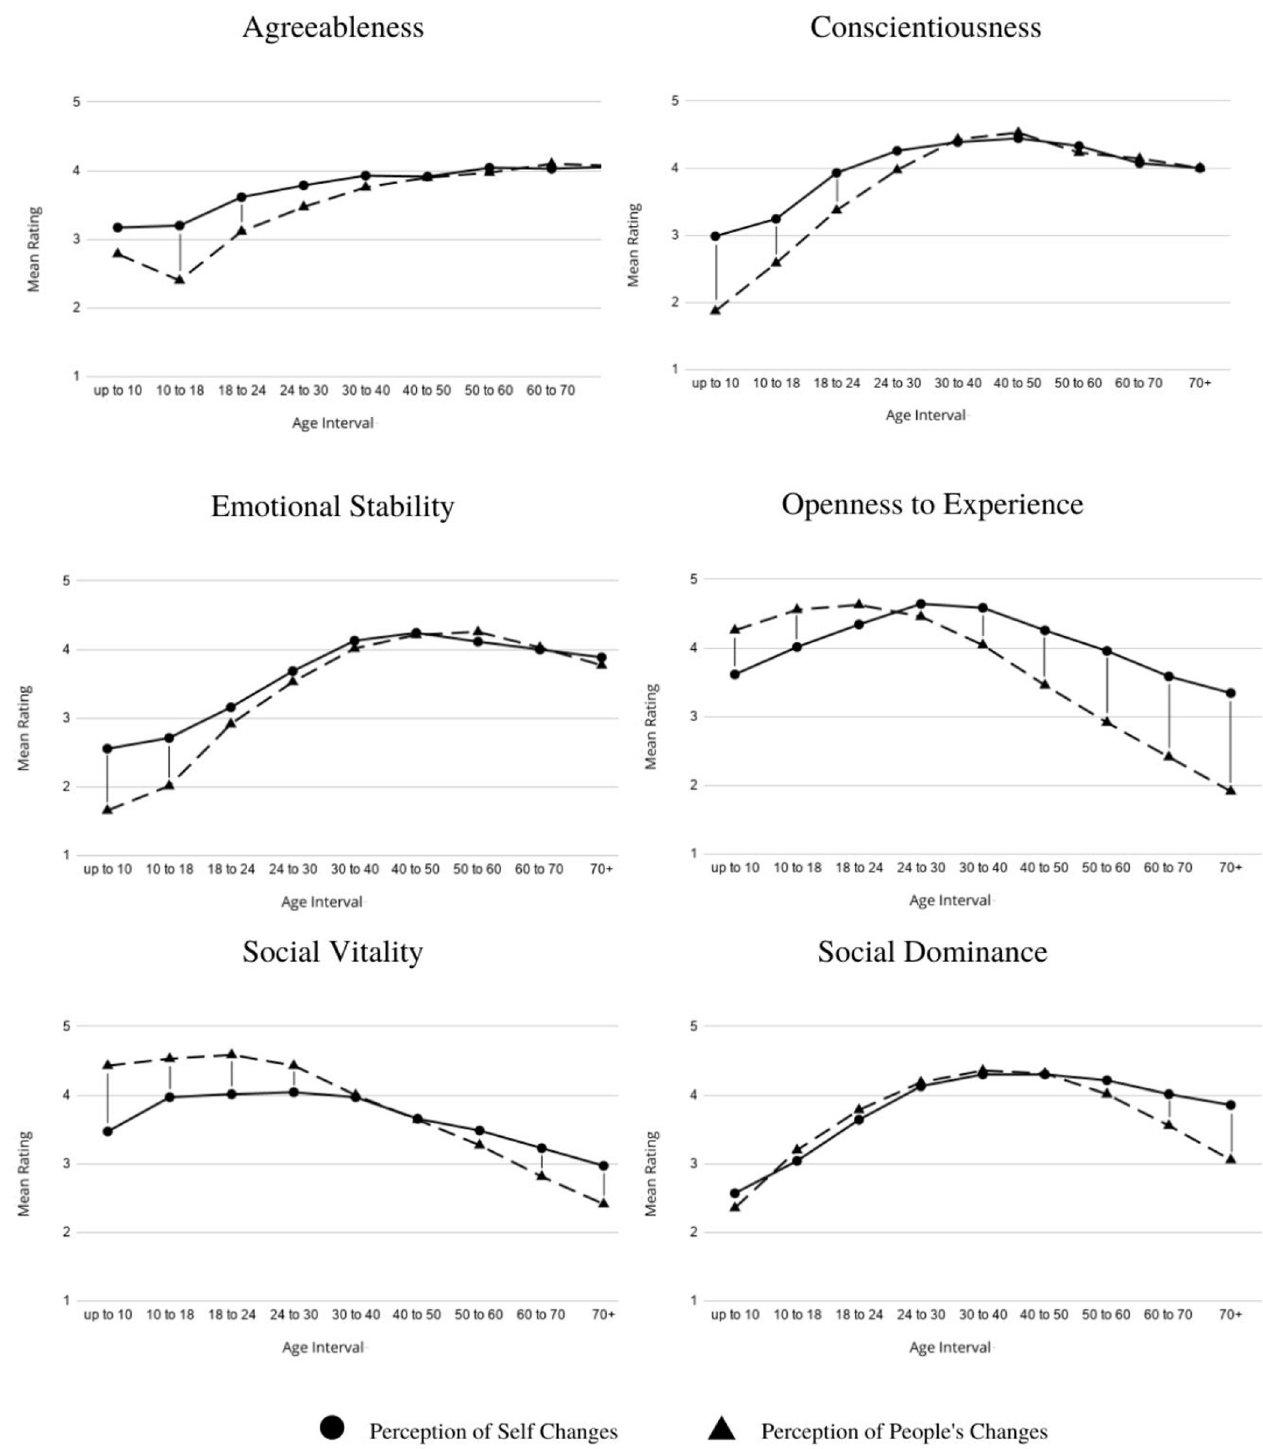
Fig 1. Mean ratings for the perception of changes of the self and the perception of people’s changes over the given age intervals across the lifespan for FFM trait.